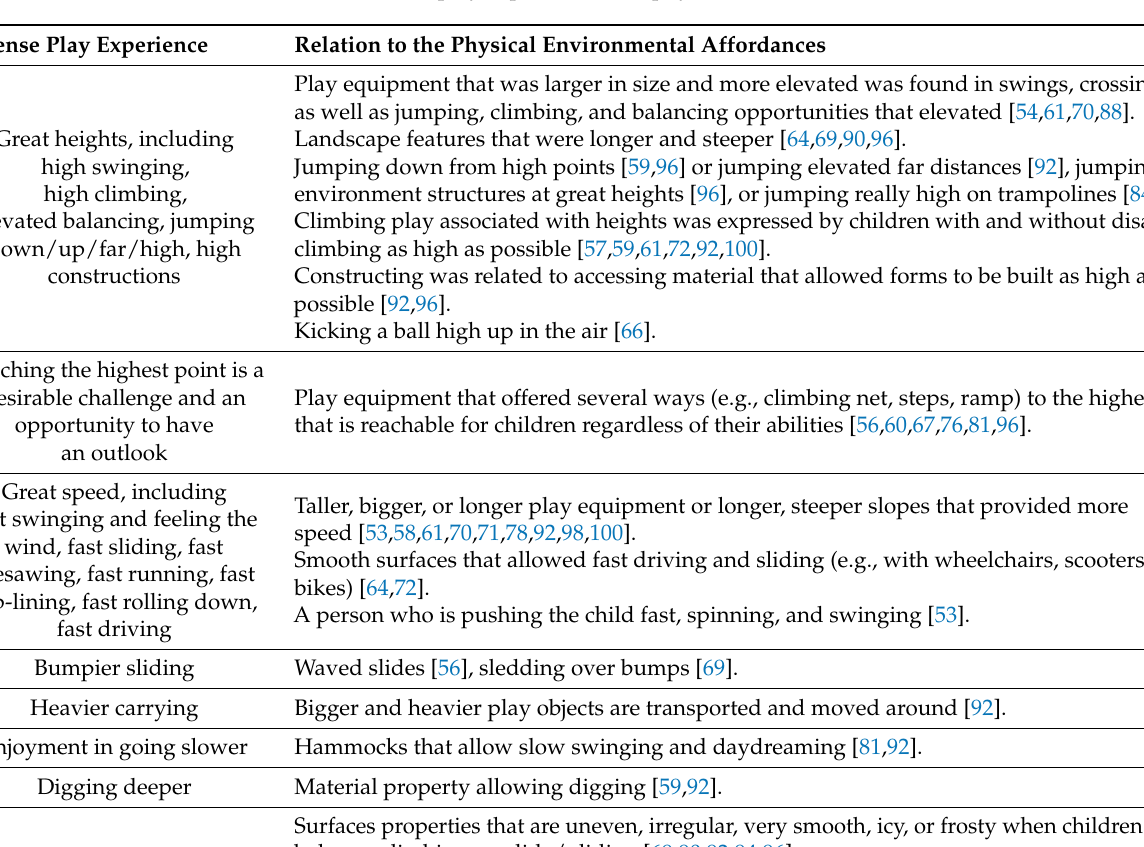
Table 5. Intense play experiences and physical environmental